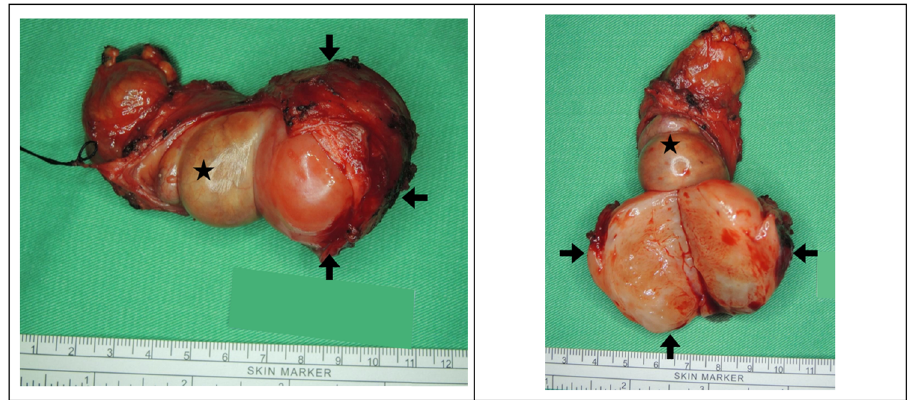
Figure 2: A white, grayish, well - circumscribed, solid tumor ( 4 × 3.5 cm ) adherent to atrophic testis and epididymis ( arrow: tumor; star: testis ) .